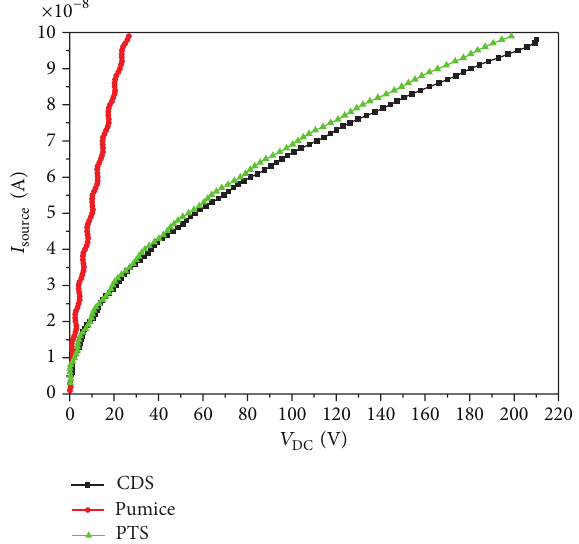
Figure 4: 𝐼 - 𝑉 graph of the volcanic rocks.